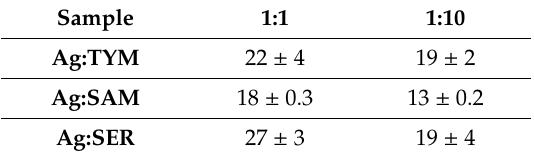
Table 2. Crystallite size (nm) of washed Ag:plant 1:1 and 1:10 samples. Sample